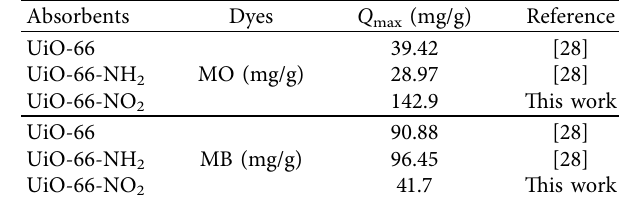
Table 1: Adsorption capacities of zirconium-based MOFs for MB and MO.